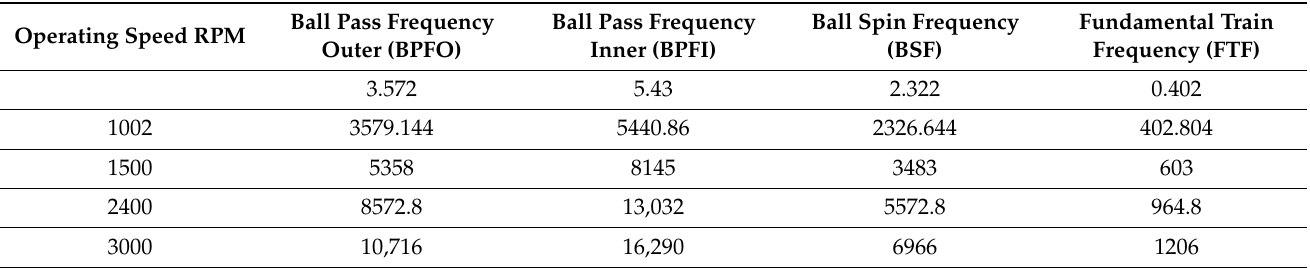
Table 1. The characteristic fault frequency multipliers of roller bearings used in this